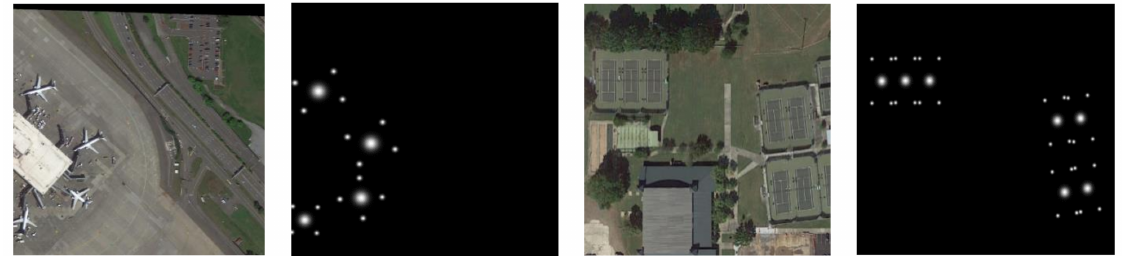
Figure 12. Raw image and corresponding attention mask